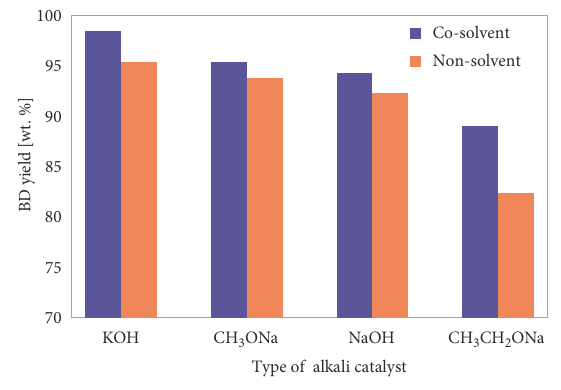
Figure 7. Influence of the alkali catalyst type on BAO